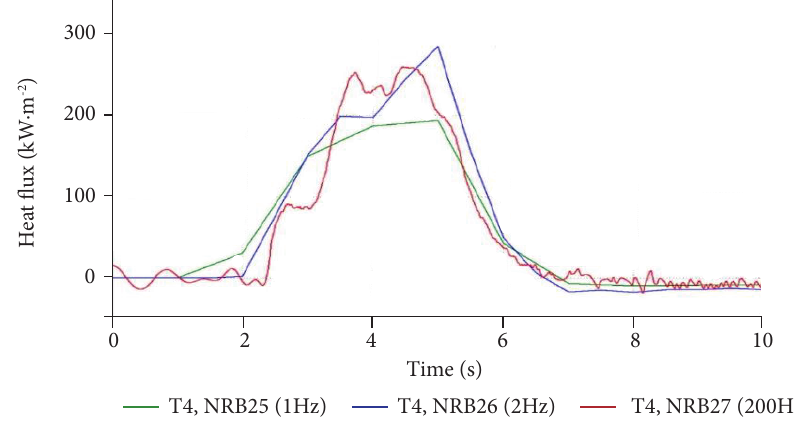
Figure 11. Heat flux from temperature history of thermocouple T4, of NBR25, 26 and 27.